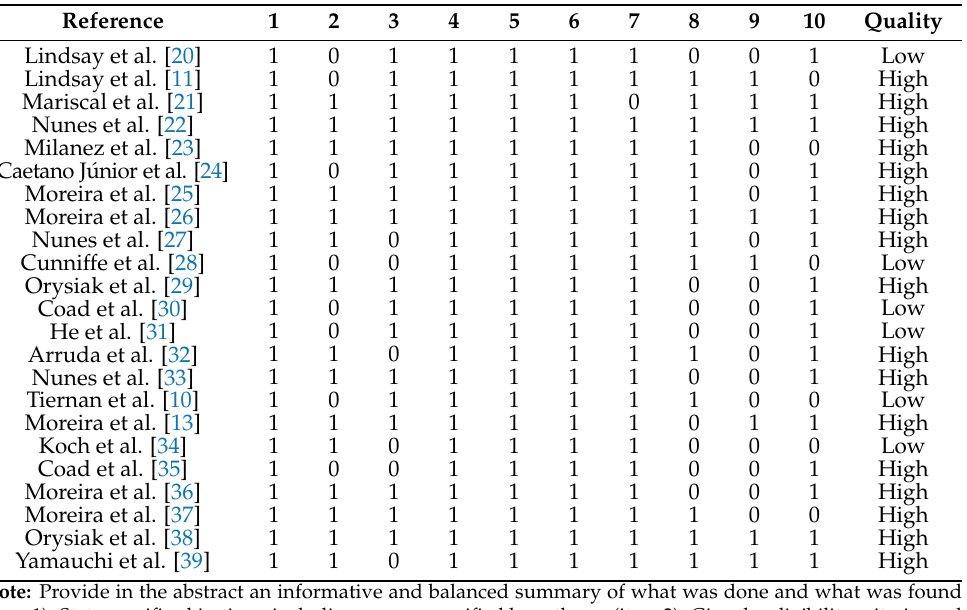
Table 2. Methodological assessment of the included